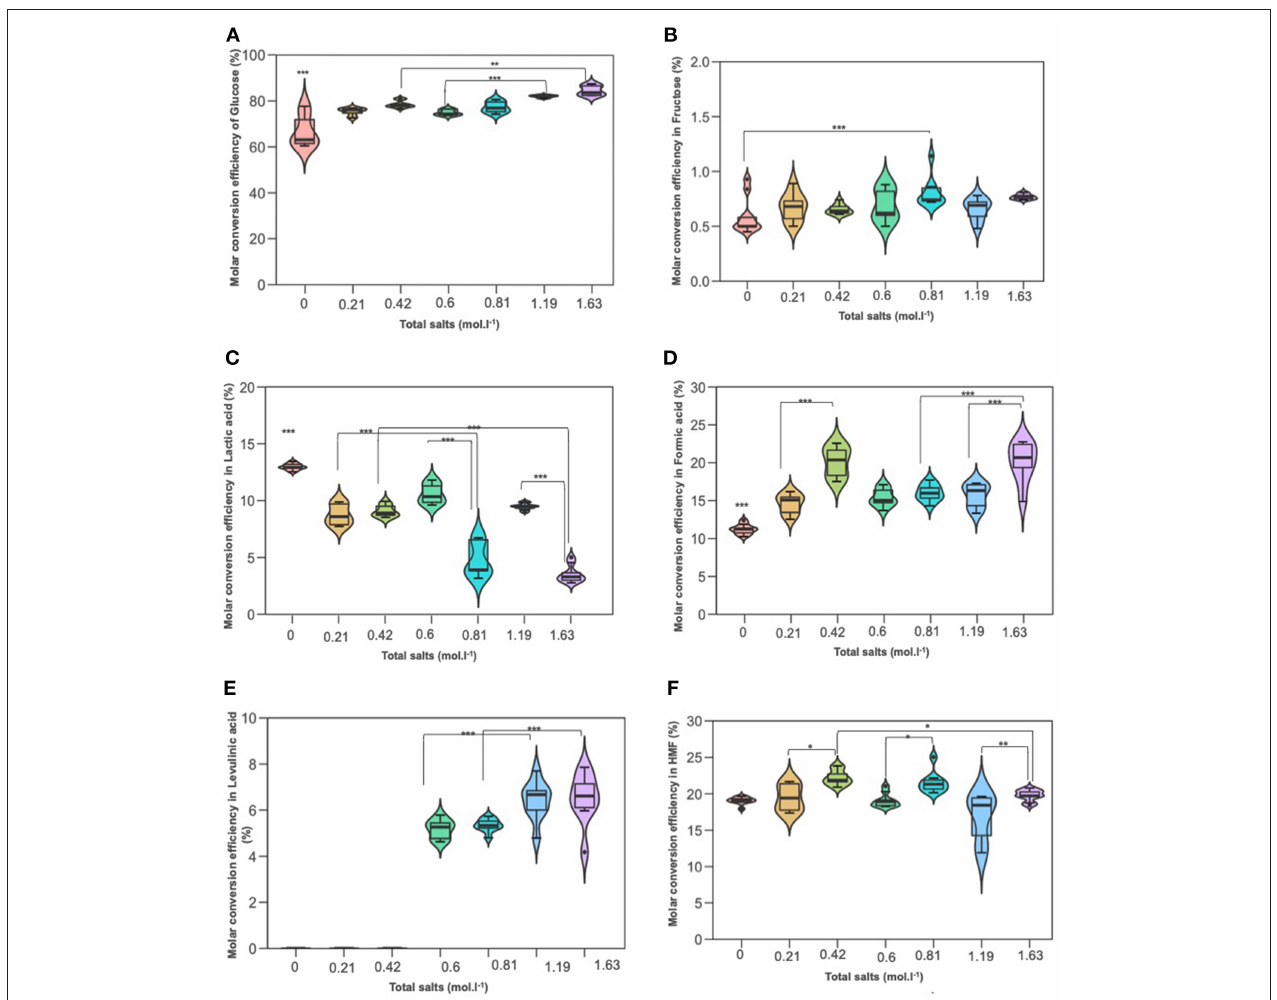
FIGURE 6 | The effect of adding NaCl and KI in hydrothermal dehydration of D-glucose: (A) molar conversion efficiency of D-glucose, (B) molar conversion efficiency to fructose, (C) molar conversion efficiency to lactic acid, (D) molar conversion efficiency to Formic acid, (E) molar conversion efficiency to levulinic acid, and (F) molar conversion efficiency to HMF. Molarities 0; 0.21; 0.42; 0.6; 0.81; 1,19; 163 corresponding g/L to deionized water; 35KI; 70KI; 35NaCl; 35 KI + 35NaCl; 70NaCl; Q19 70KI + 70NaCl, respectively. * P < 0.05; ** P < 0.01; *** P <